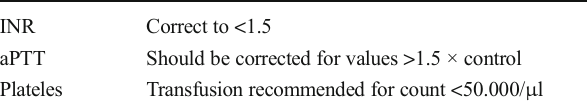
Abnormalvaluesthat shouldbecorrectedbeforethe procedure Patient management before procedures with moderate risk of bleeding INR